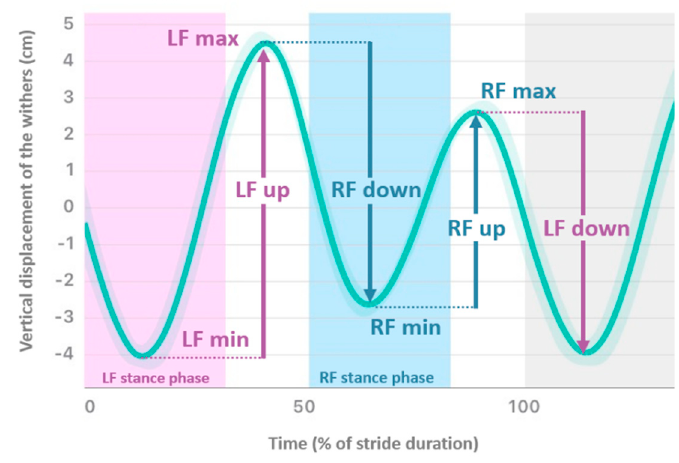
Figure 2. Mean vertical displacement (cm) of the withers plotted against time (expressed as % of stride duration) of a horse showing right forelimb (RF) lameness. Asymmetry Indices (AI) are: AI- min=RFmin-LFmin/LFup; AI-max=LFmax-RFmax/LFup; AI-up=LFup-RFup/LFup; AI- down=LFdown-RFdown/LFdown. (LF- Left Forelimb).